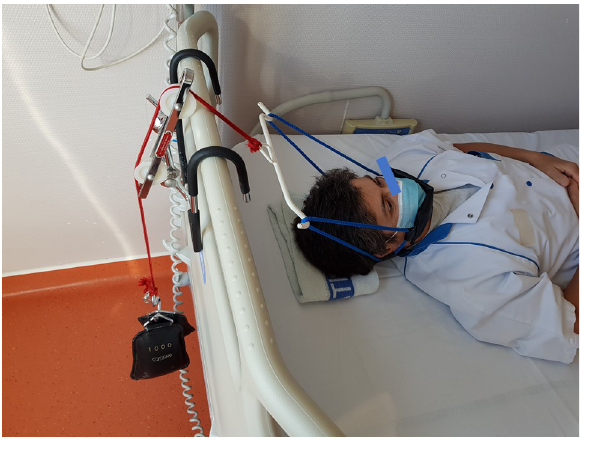
Fig 1. Cervical traction